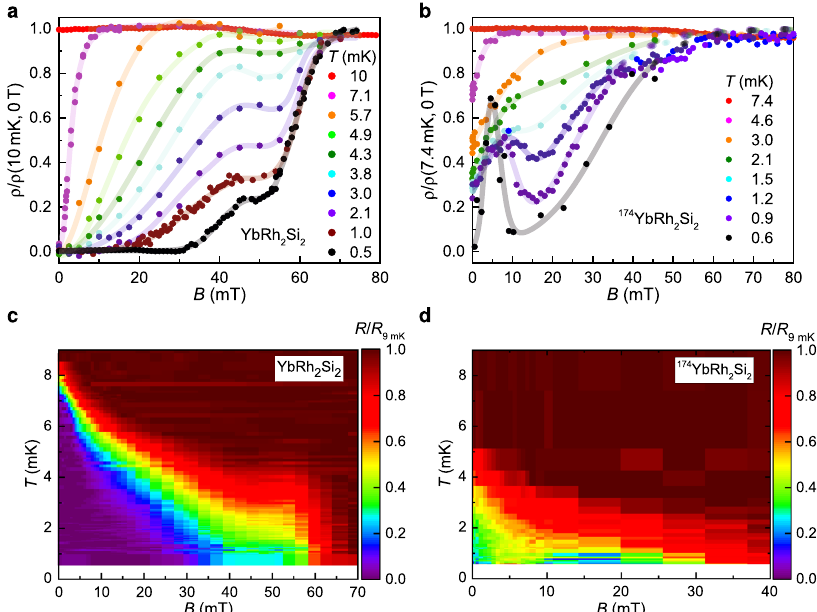
Fig. 3 Magnetic fi eld dependence of the electrical resistivity of YbRh 2 Si 2 and 174 YbRh 2 Si 2 . a , b Selected isotherms of the electrical resistivity ρ ( B ), revealing reentrant superconductivity at low temperatures in 174 YbRh 2 Si 2 ( b ) and remnants thereof in YbRh 2 Si 2 ( a ). Lines are guides-to-the-eyes in ( a ) and fi ts to a multi-transition model (Supplementary Note 1: Analysis of resistivity vs magnetic fi eld isotherms and Supplementary Fig. 1) in ( b ). c , d Temperature-- magnetic fi eld phase diagrams of the two samples, with the reduced electrical resistance R / R (9mK) as color code. The yellow color corresponds to the resistive midpoint. As a measure of T c ( B ) it indicates a phase boundary of unusual shape for YbRh 2 Si 2 , and two possibly distinct phases for 174 YbRh 2 Si 2